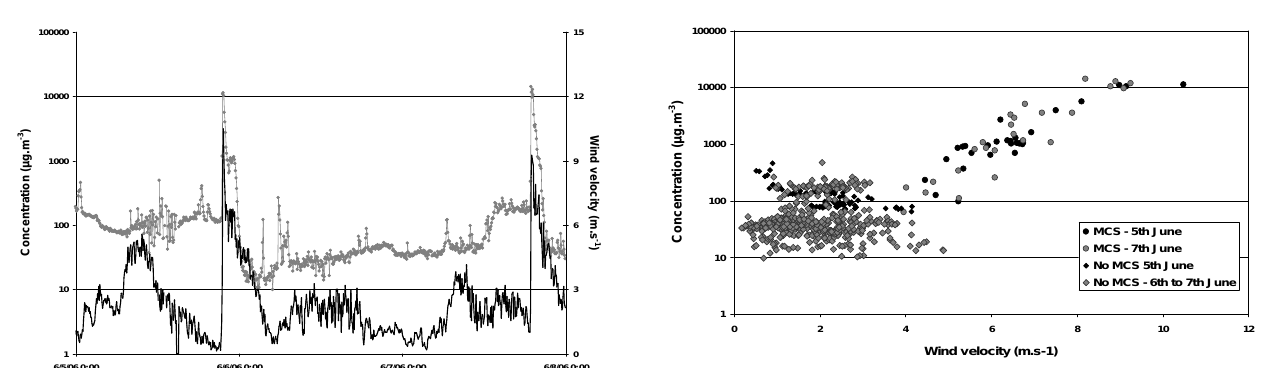
Fig. 15. 5-min surface wind velocities (black line) and PM 10 con- centrations measured in Cinzana from 5 to 8 June 2006.